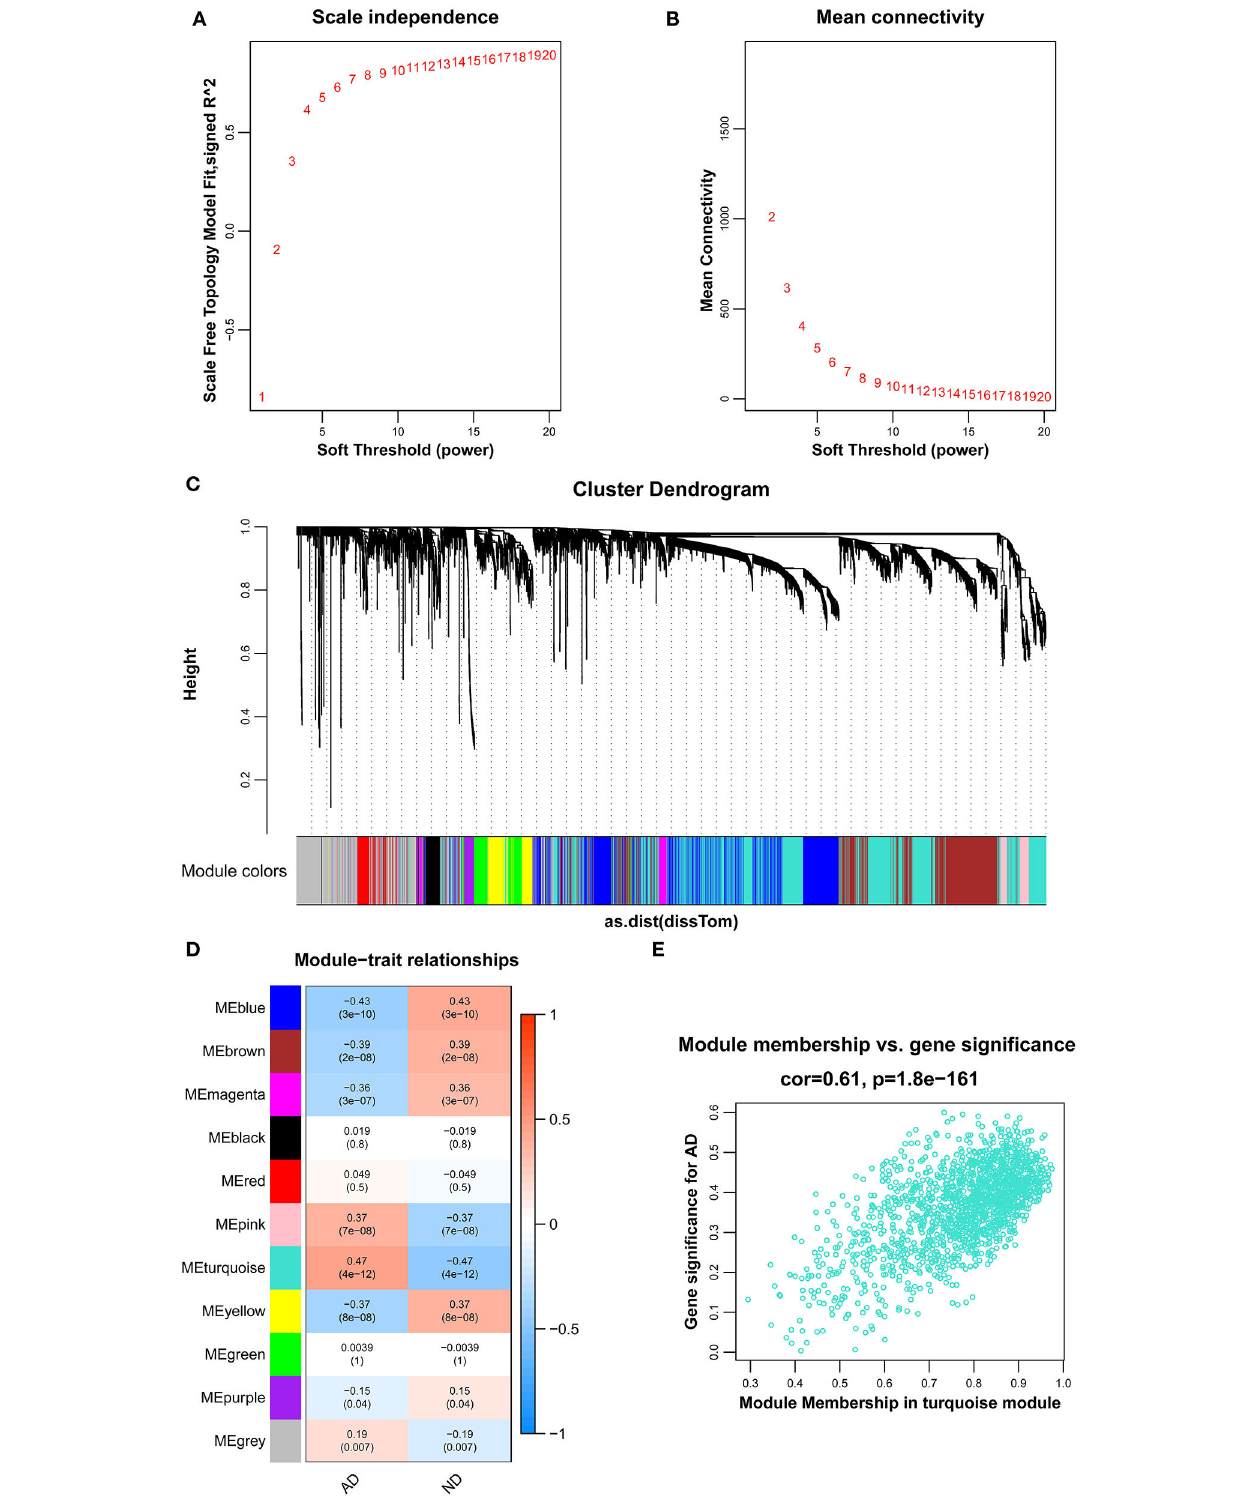
FIGURE 3 | Results of the WGCNA. (A) The corresponding scale-free topological model fit indices at different soft threshold powers. (B) The corresponding mean connectivity values at different soft threshold powers. (C) Cluster dendrogram of genes. (D) Correlations between different modules and clinical traits. Red represents a positive correlation, and blue represents a negative correlation. (E) Correlation of module membership and gene significance in the turquoise module.